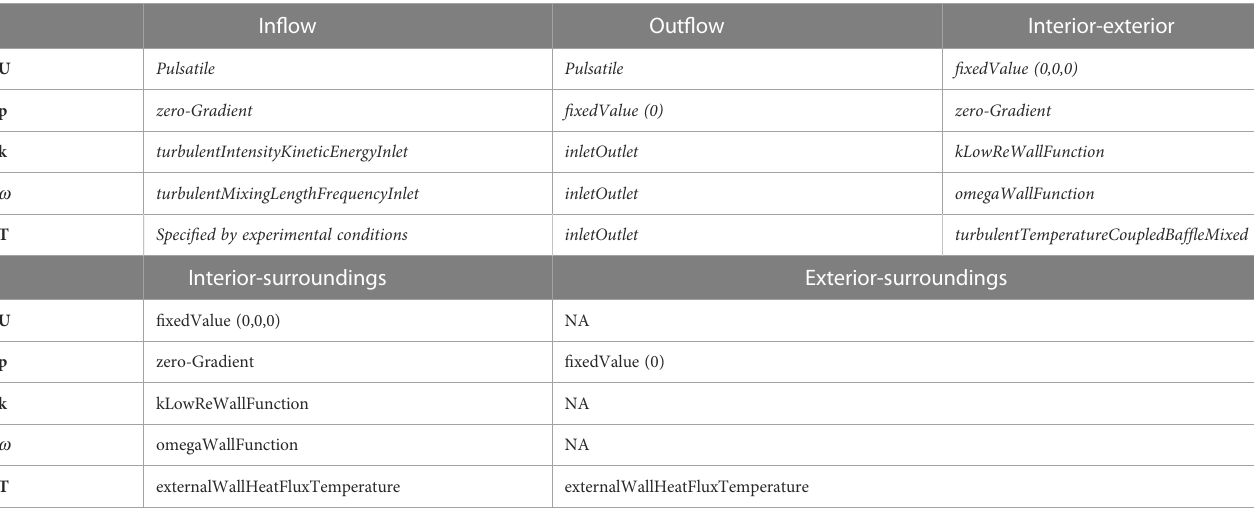
TABLE 2 Boundary conditions used in this